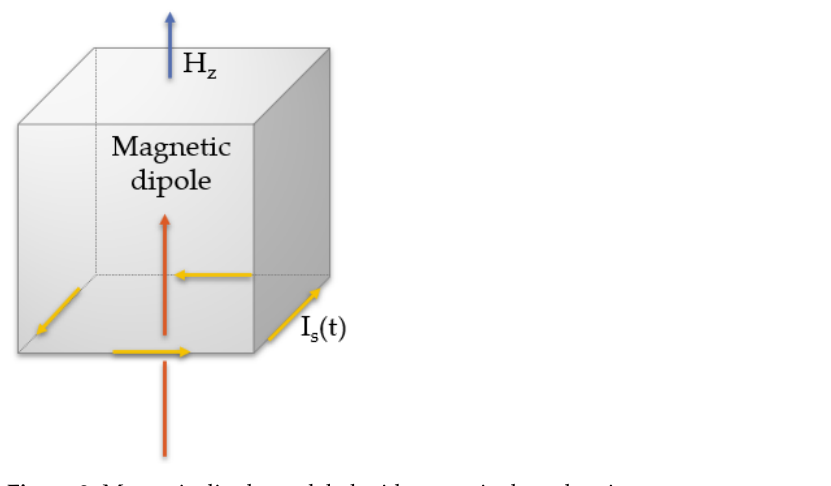
Figure 2. Magnetic dipole modeled with an equivalent electric current.